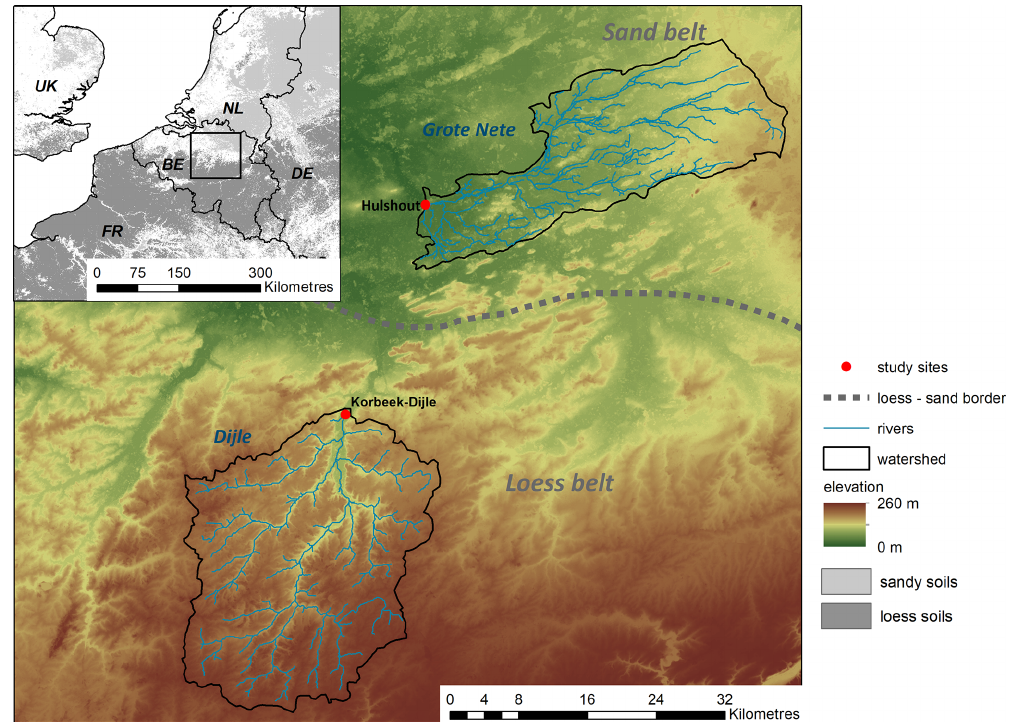
Figure 1. Location of the two studied river basins (Dijle and Grote Nete), with indications of the floodplain study sites and the border between the sand and loess belts. The mapping of the sandy and loess soils is derived from the Topsoil physical properties for Europe dataset (ESDAC) (Ballabio et al.,